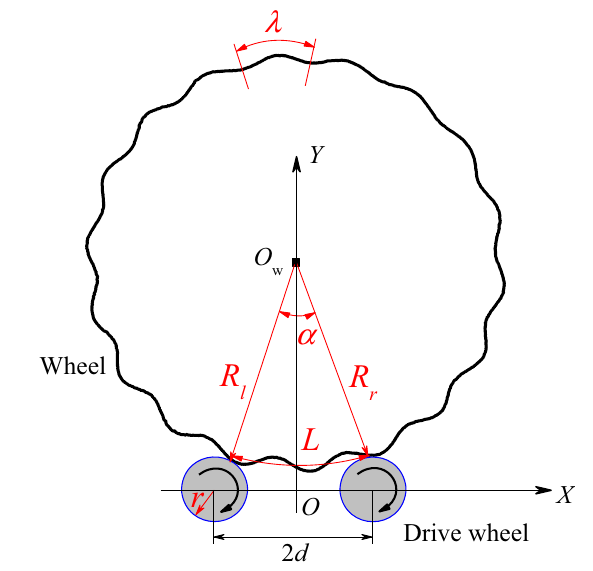
Fig. 21 Geometric relationship between the polygonised wheel and drive wheels of the underfloor wheel lathe